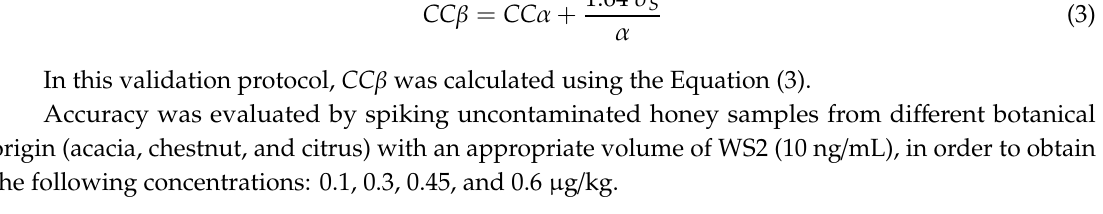
Supplementary Materials: The following are available online, Figure S1: Evaluation of preliminary extraction recoveries on three di ff erent botanical honey under optimized experimental design conditions, Figure S2: Evaluation of preliminary matrix e ff ects on three di ff erent botanical honey at three concentration levels under optimized experimental design conditions. Figure S3: Theoretical (a) and experimental (b) isotopic pattern of CAP in negative ion mode. Table S1: Design matrix for the 24-Factorial design and obtained result for each